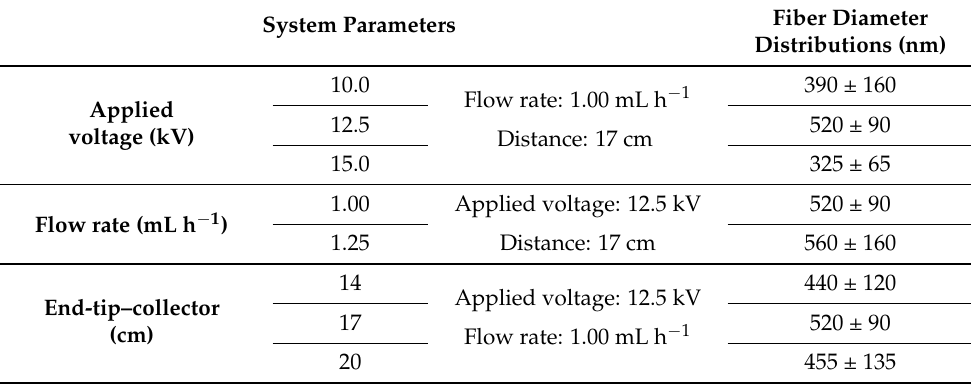
Table 4. The effect of system parameters applied for the fabrication of TPU fibers containing 20 wt % LO on the fiber diameter. System Parameters Fiber Diameter